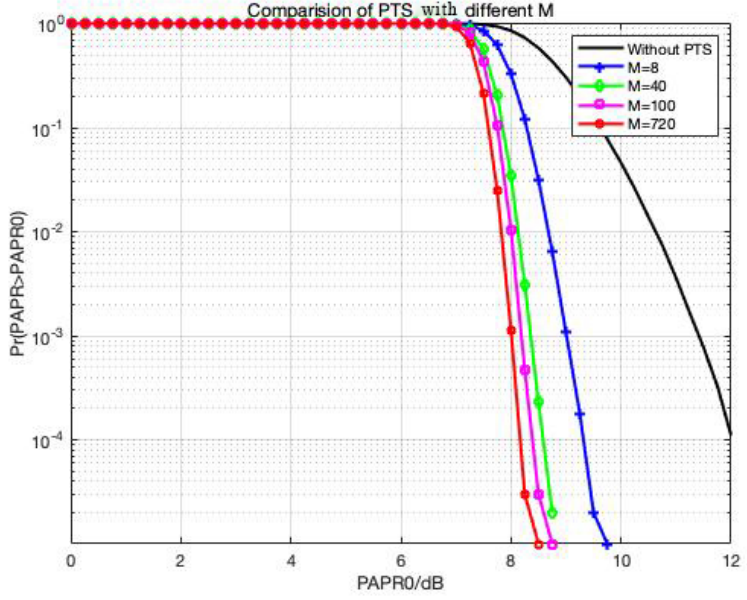
Figure 9. Comparison of PTS with different M .